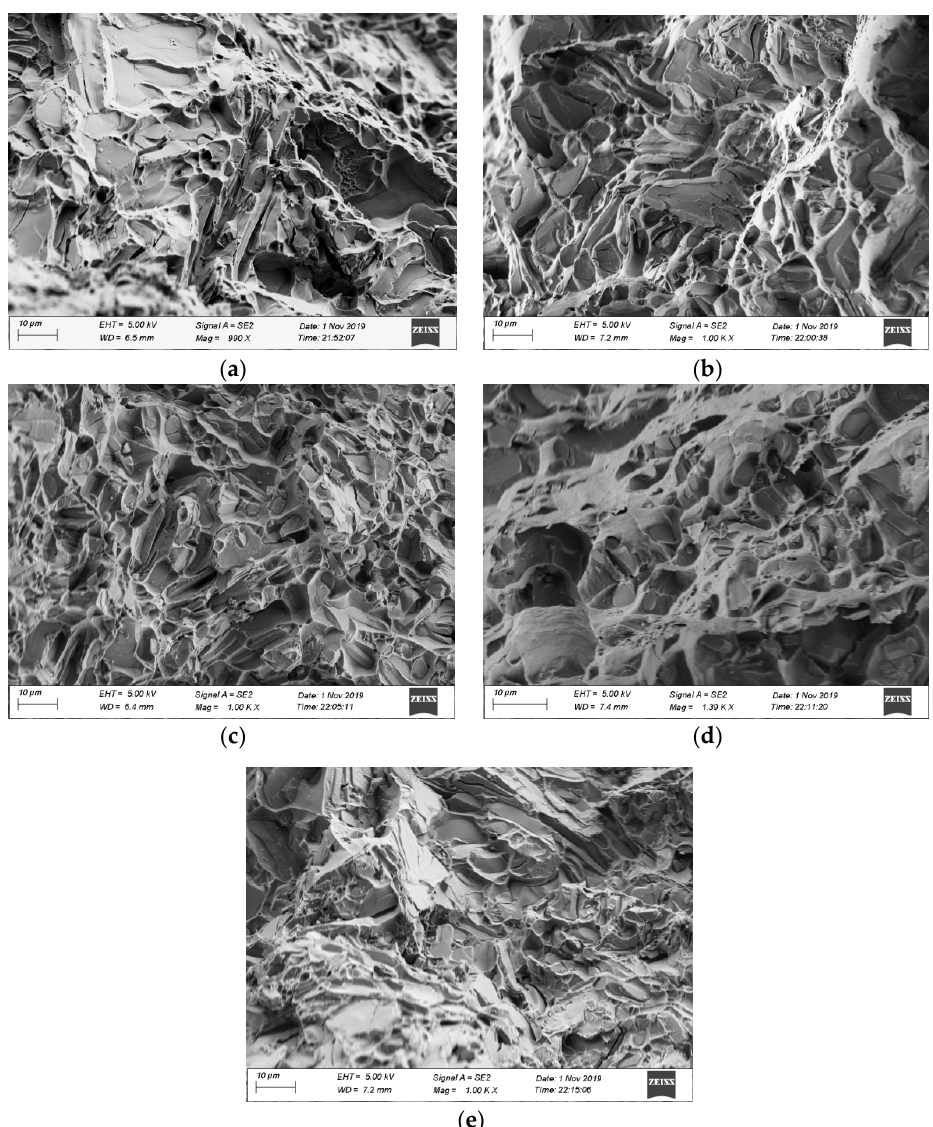
Figure 18. Tensile fracture morphology characteristic of the alloys. ( a ) 0% ( b ) 0.08%, ( c ) 0.16% ( d ) 0.24%, and ( e ) 0.32%.